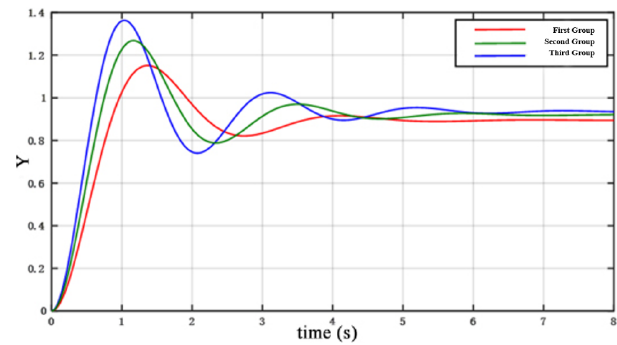
Figure 4. System response curve (test ˆ λ 2 and ˆ λ 3 ). Figure 5. System response curve (test ρ